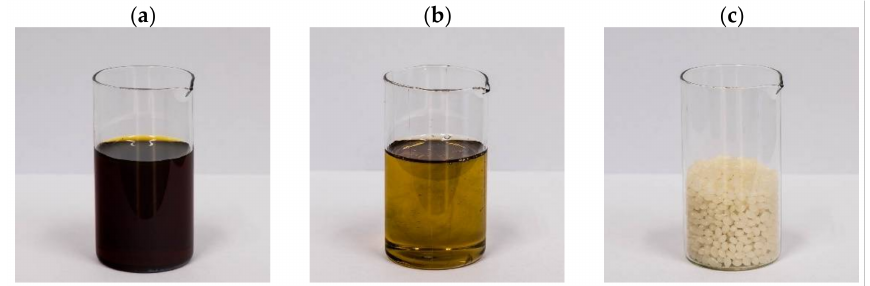
Figure 1. Photographs of the studied additives: ( a ) Wetfix BE, ( b ) Rediset LQ, and ( c ) Sasobit. Table 2. Characterization of the reference 35/50 and 50/70 road-paving bitumen used as a base for the investigated binders. Property